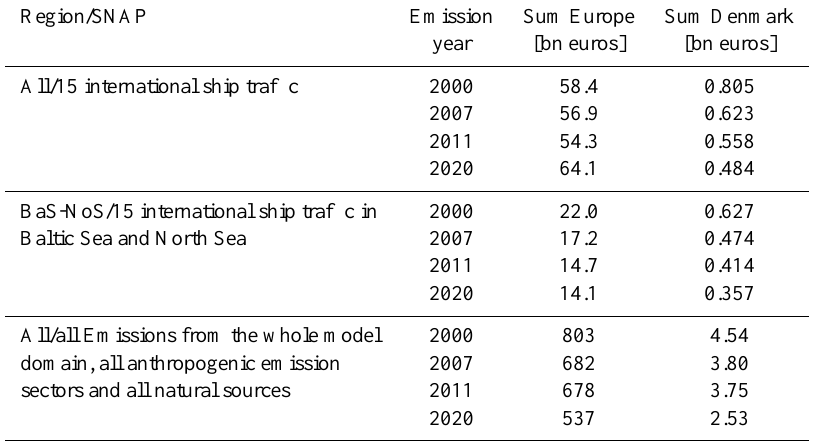
Table 6. Total health-related externalities for Europe and Denmark for international ship traffic (All/15), for international ship traffic in the Baltic Sea and the North Sea (BaS-NoS/15), and for all emissions in the whole of Europe (All/all) for four different emission years. All costs are in 2006 prices. All external costs are given in billion (bn)